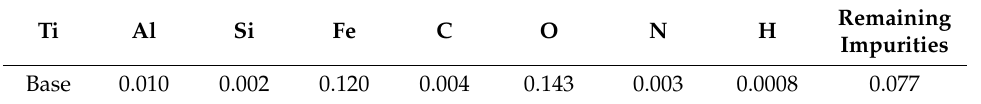
Remaining Impurities